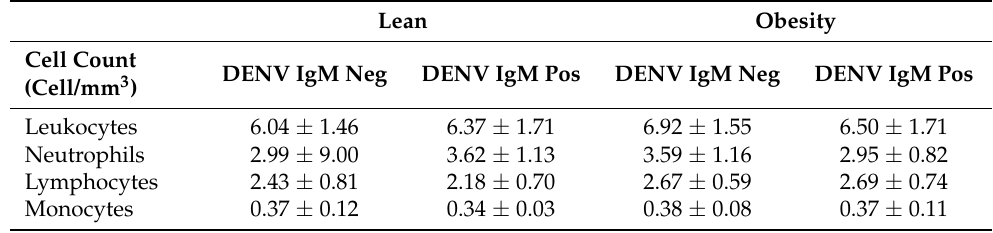
Table 3. Global and differential leukocyte count of the study’s